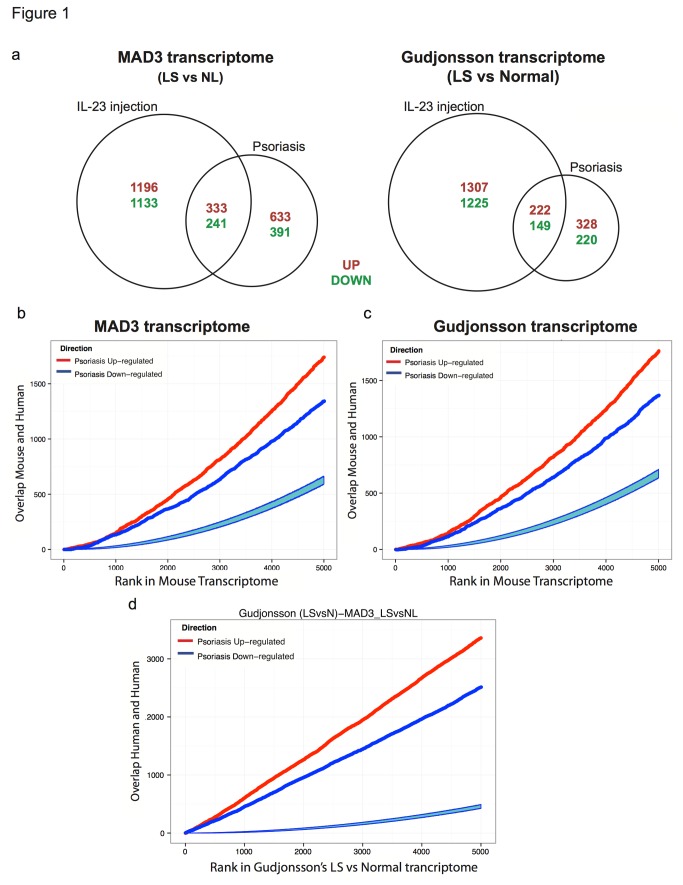
Murine IL-23 induced model of inflammation corresponds to the human psoriasis phenotype: Statistically significant overlap of DEGs and ranked gene lists.A. Venn diagrams illustrate relative overlap of orthologous DEGs between human psoriasis and the IL-23-induced mouse model. There are 10% more common DEGs between the IL-23 mouse model and MAD3 compared to that with Gudjonsson(LSvsNormal). B, C. Overlap between top k up- (red lines) and k down-regulated (dark blues lines) genes in the IL-23 transcriptome and the murine orthologs of the human MAD3 and Gudjonsson(LSvsNormal) transcriptomes, respectively, was estimated for k=1,…5000.. D. As a reference, the overlap between both human transcriptomes was analyzed in similar fashion. Statistically significant overlap is seen for all three depictions of ranked gene overlap, as the light blue regions represent degree of overlap expected under the null hypothesis of random overlap.